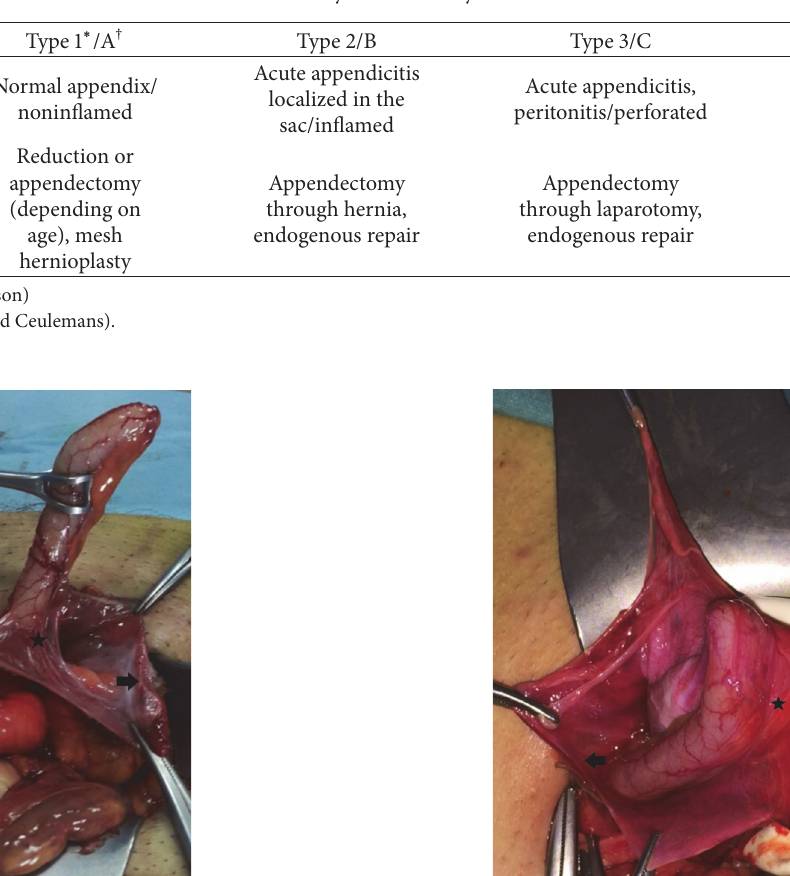
Table 1: Classification systems for Amyand’s hernia.